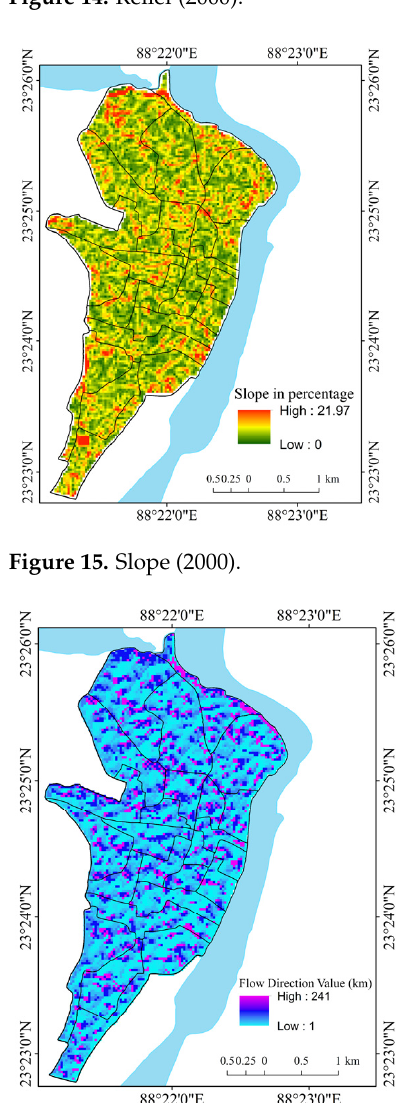
Figure 17. Flow distance (2000). Figure 18. Flow length (2000).